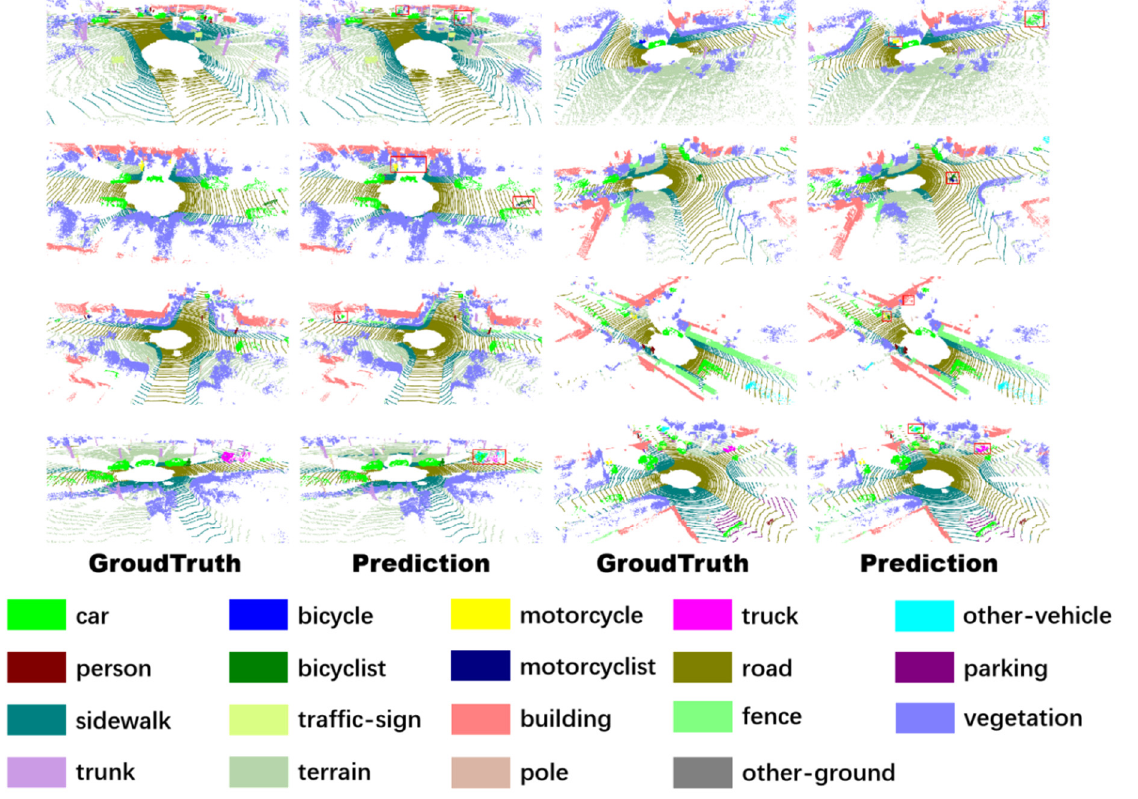
Figure 10. The prediction of SemanticKITTI (single-scan). Red rectangles show the main mispredicted regions.